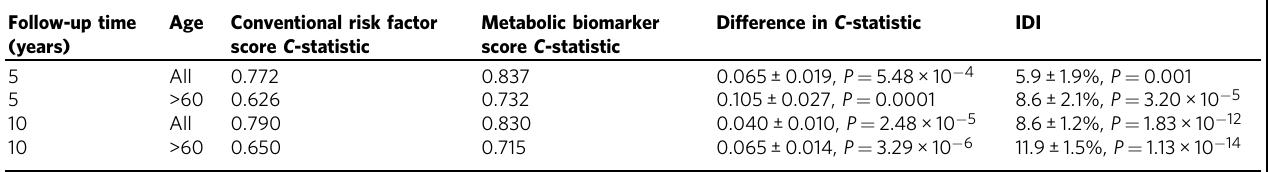
Table 4 Results of the discrimination and reclassi fi cation analyses for all-cause mortality in the FINRISK 1997 cohort comparing the conventional risk factor score with the metabolic biomarker